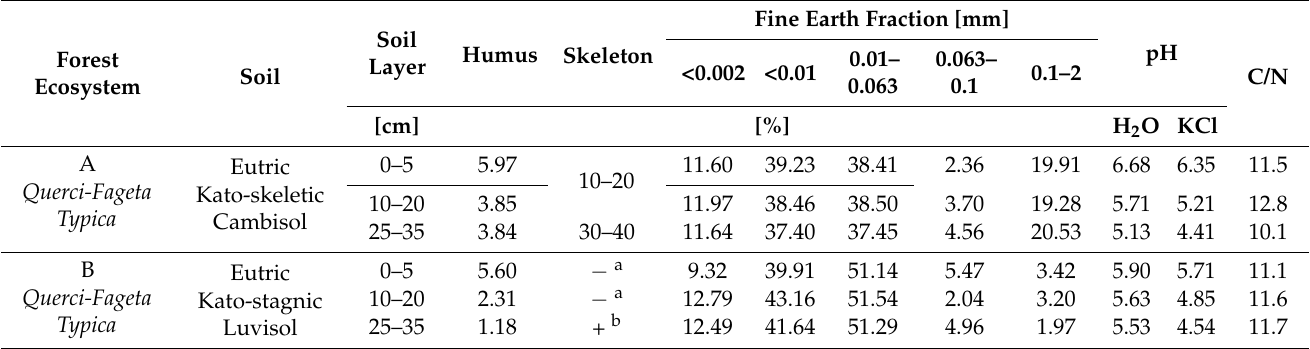
Table 3. Selected properties of the soils. a – without skeleton; b + up to 5%